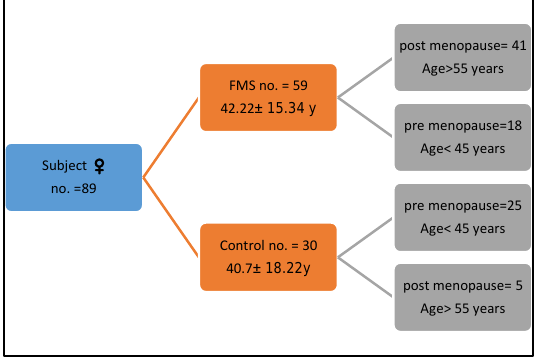
Figure1. Demographic distribution of volunteers (FMS and control) according to age in this study .